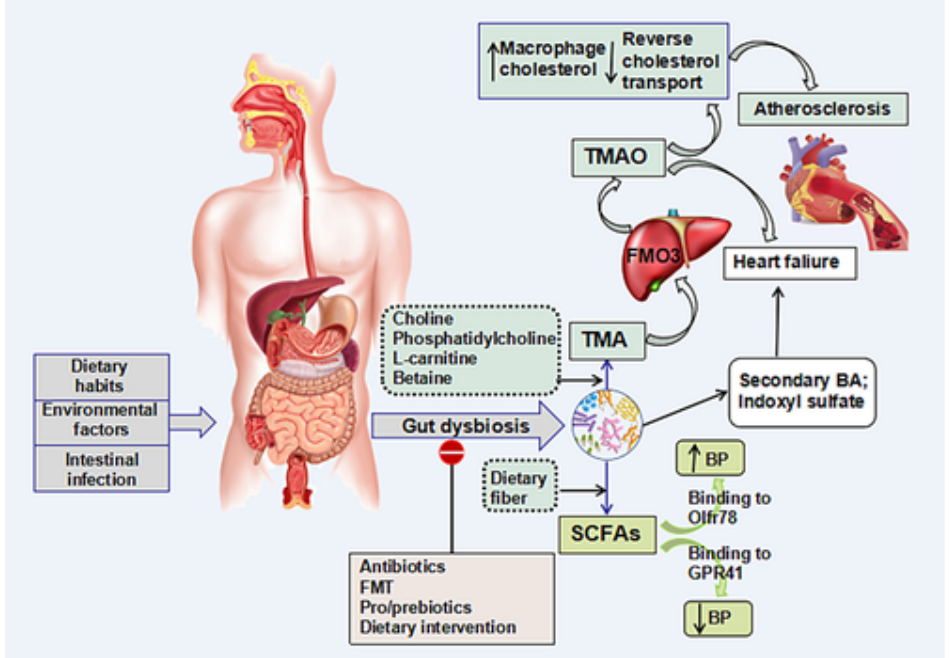
Figure A1. The role of intestinal microbiota in cardiovascular diseases. The figure is adapted with permission from 2019 Jin M. et al. [11].